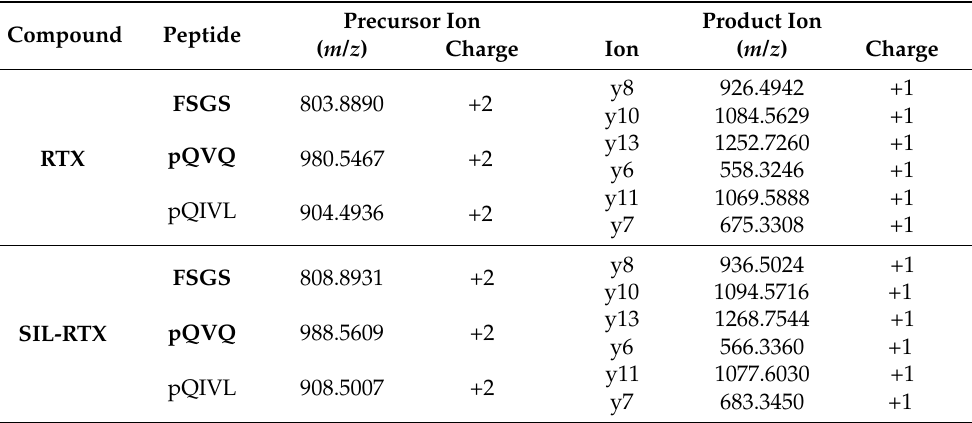
Table 1. Surrogate peptides pre-selected for Rituximab (RTX) quantification by LC-MS/HRMS using the full-length stable isotope-labeled rituximab (SIL-RTX). Peptides in bold were used for the quantification.